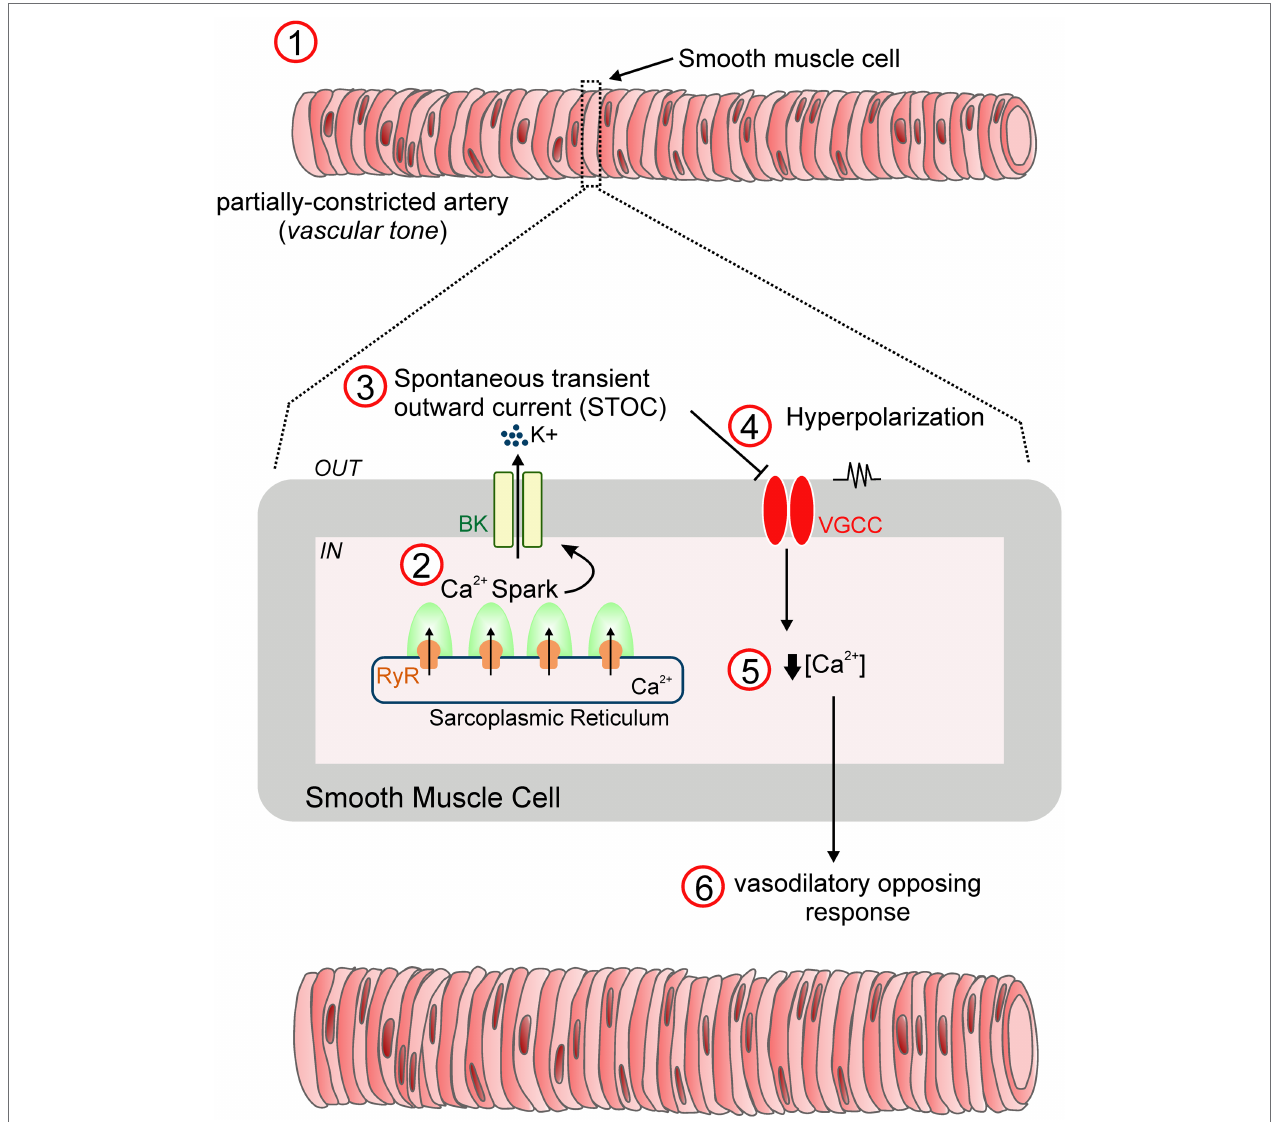
FIGURE 2 | STOC-mediated vasodilation mechanism. In vascular smooth muscle, BK channels are key drivers of negative feedback control via the regulation of membrane excitability, an essential mechanism that prevents excessive constriction of resistance arteries (1). Specifically, transient activation of ryanodine receptors (RyR) residing in the sarcoplasmic reticulum leads to the generation of “Ca 2+ sparks” (2). Single sparks increase the Ca 2+ concentration in the vicinity of membrane BK channels, provoking their opening and the subsequent development of macroscopic K + currents referred to as “Spontaneous transient outward currents (STOCs)” (3). This in turn, contributes to membrane hyperpolarization by reducing the voltage-gated Ca 2+ channel (VGCC) open probability (4), and a relative reduction in the intracellular Ca 2+ levels (5). As a result, the resistance artery develops a dilatory response (6), a vital feedback mechanism to optimize arterial tone development (Nelson et al.,